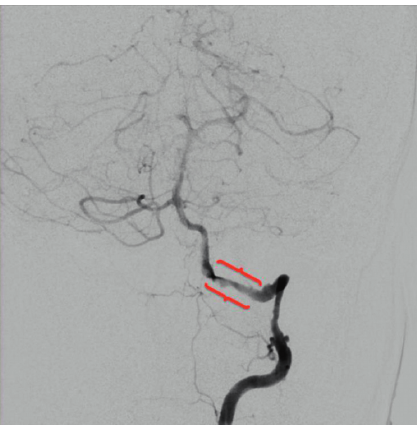
Figure 4: Cerebral angiography shows right vertebral artery dissection right past the C3 level at which a small pseudoaneurysm is noted in the artery anterior wall. This pseudoaneurysm tapers into the dissection which extends just beyond the C2 loop. There is marked reduction in luminal diameter and noticeable delay in antegrade flow distal to the dissection.